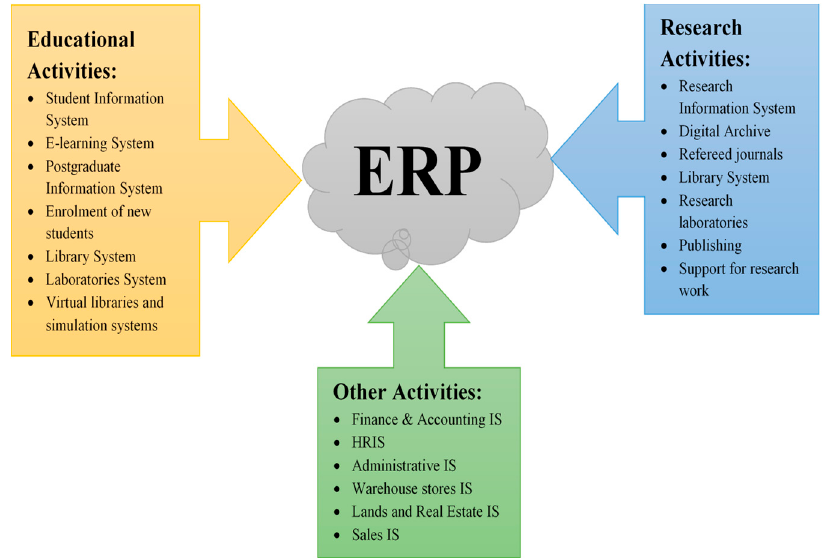
Figure 2. Cloud enterprise resource planning (ERP) for higher education (HE) institutes. This is the authors’ own work, and the activities are classified on the basis of the model of business activities in HE institutes that was presented by [4].